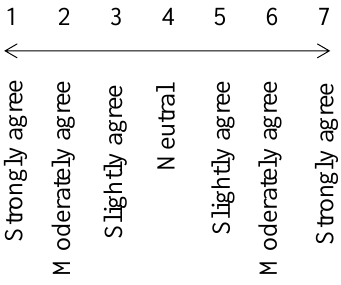
Figure 5. Seven-point scale adopted in the subjective evaluation experiment.